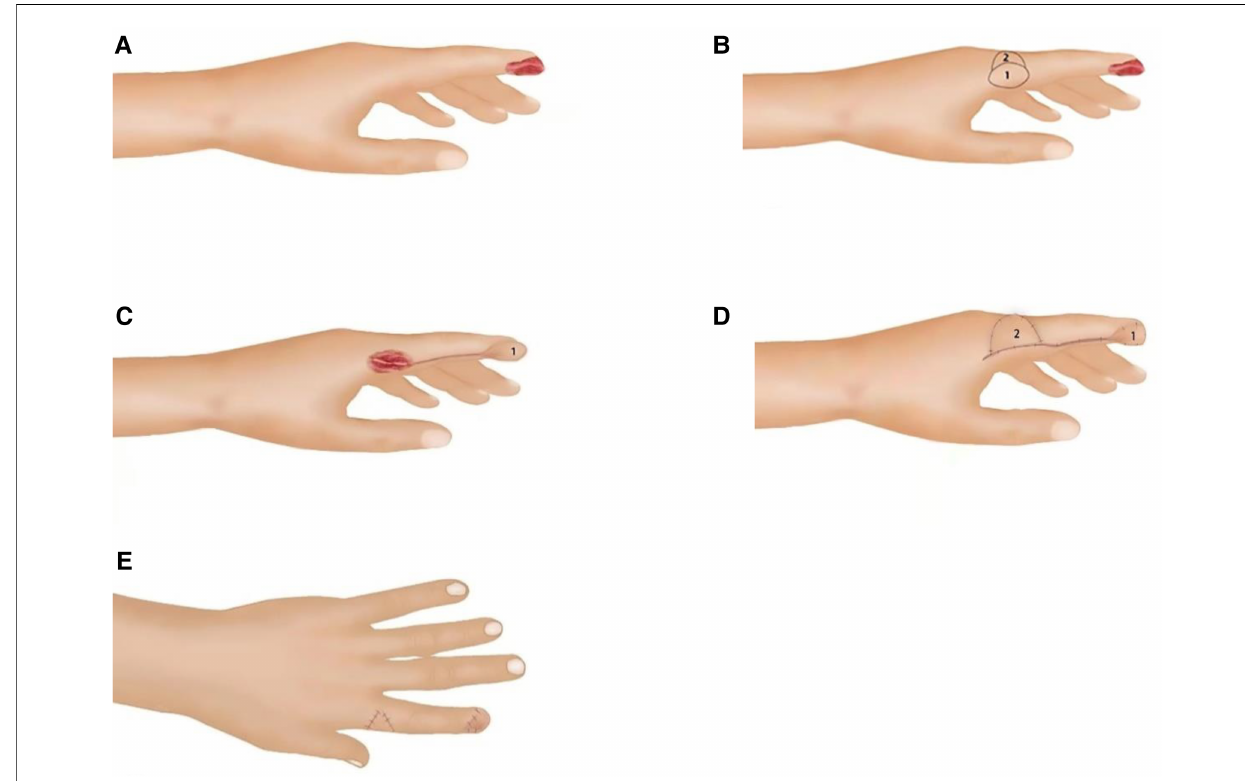
FIGURE 1 Schematic diagram of operation. ( A ) Fingertip skin defect with bone exposure; ( B ) According to the size and shape of the skin defect, the reverse digital artery island fl ap and dorsal digital advancement fl ap were designed at the proximal fi nger; ( C ) The reverse digital artery island fl ap was harvested to cover the fi ngertip skin defect maintaining the continuity of the proper digital nerve. ( D,E ) The donor area of the reverse digital artery island fl ap is covered by the reverse digital artery island fl